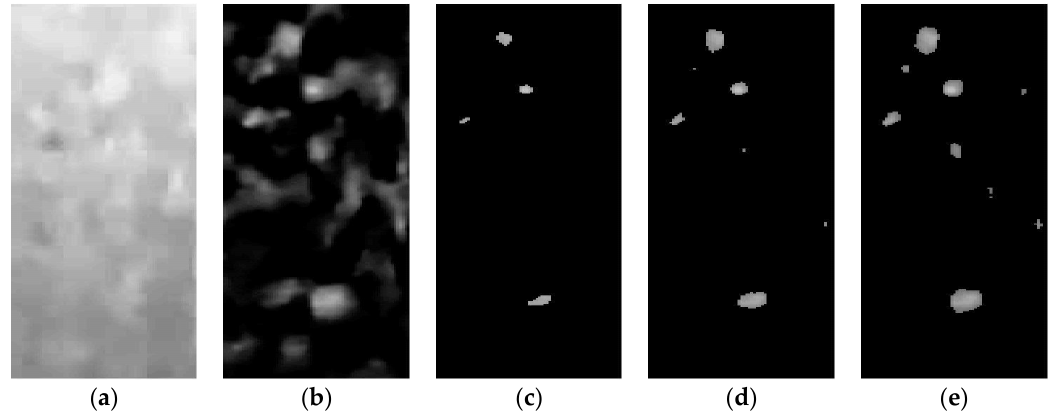
Figure A1. The effects of the Free-LSPIV pre-processing on a video frame: original greyscale ( a ), background removal ( b ), contrast adjustment with parameter 0.8 ( c ), contrast adjustment with parameter 0.7 ( d ), contrast adjustment with parameter 0.6 ( e ).